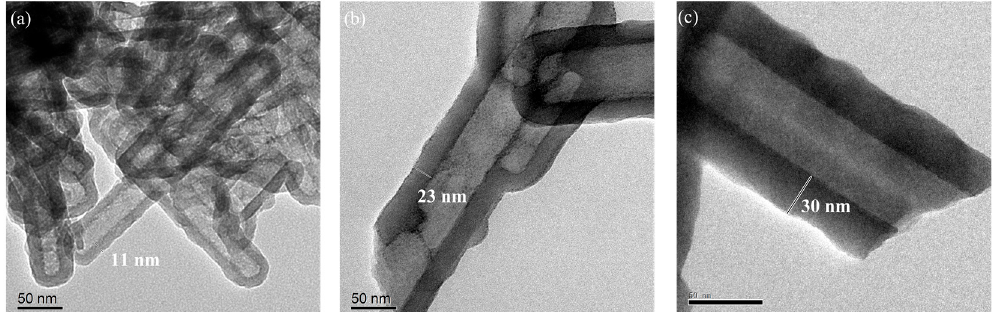
Figure 2. TEM images of ( a ) SiO 2 − 1, ( b ) SiO 2 − 2, ( c ) SiO 2 − 3.